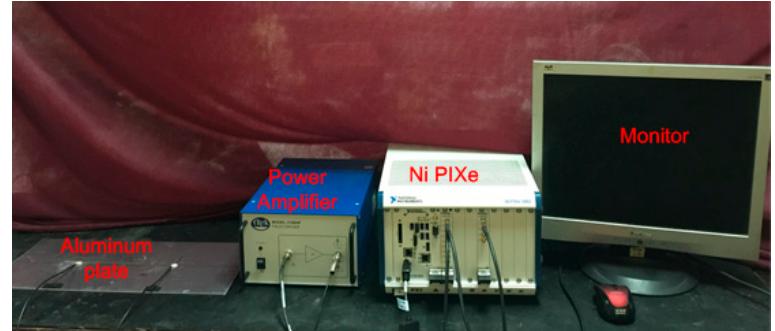
Figure 3. The experimental setup with the data acquisition system.